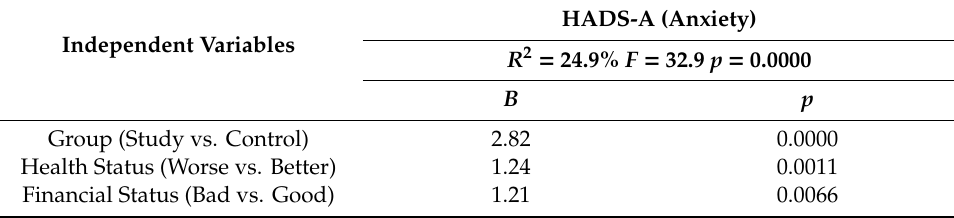
Table 4. Regression model for predicting HADS-A.